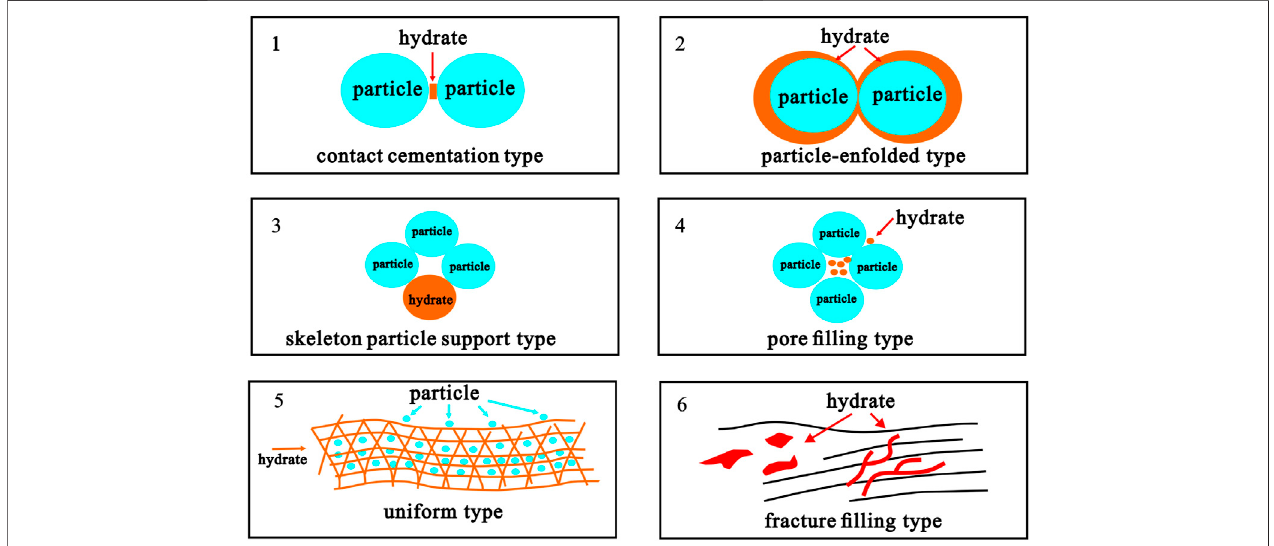
FIGURE 5 | Enrichment diagram of fi ve classical hydrate